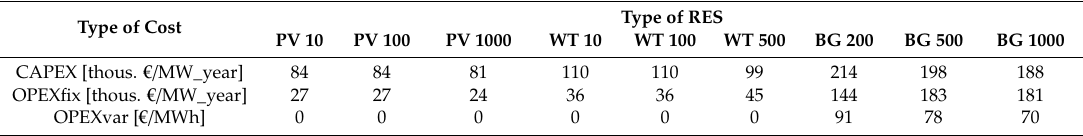
Table 3. Costs of RES